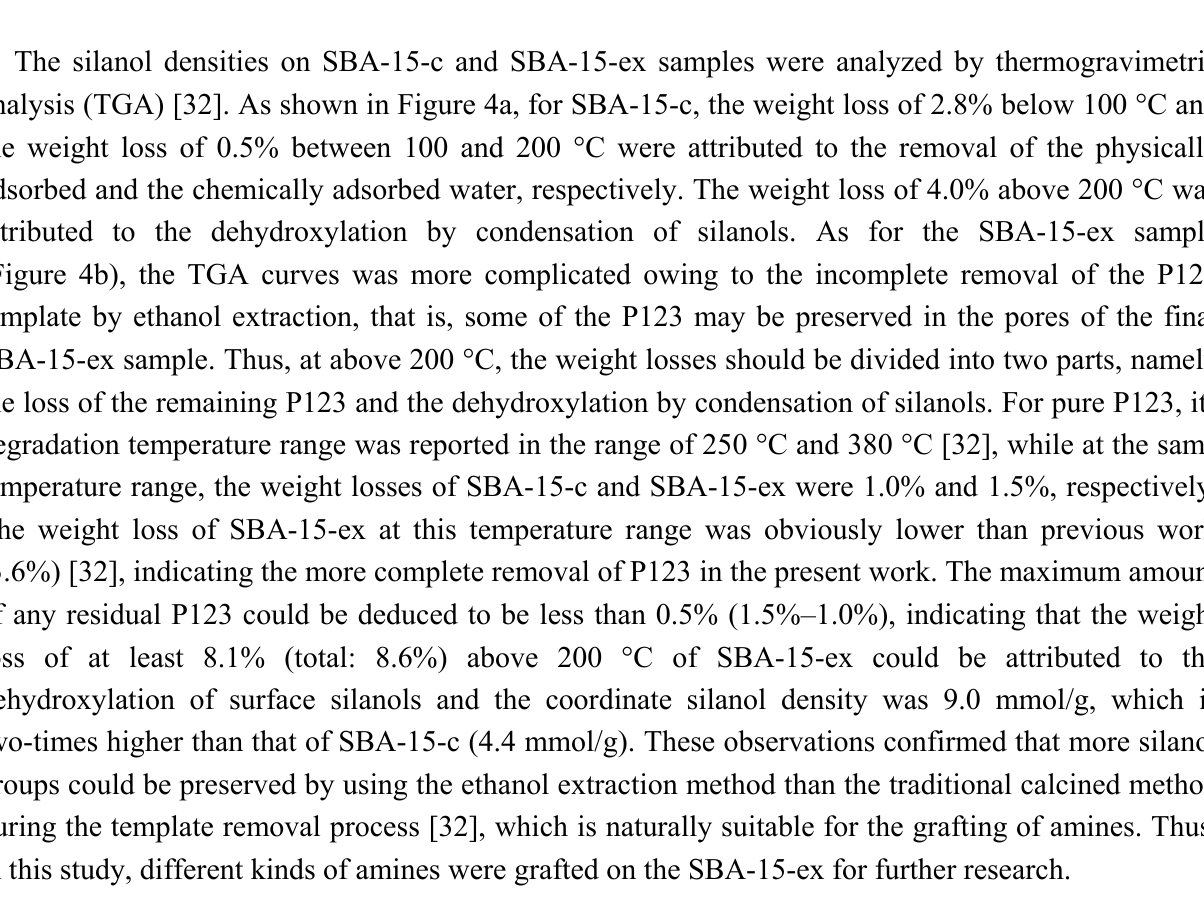
Figure 4. Thermogravimetric analysis (TGA) curves of a: SBA-15-c; b and SBA-15-ex.